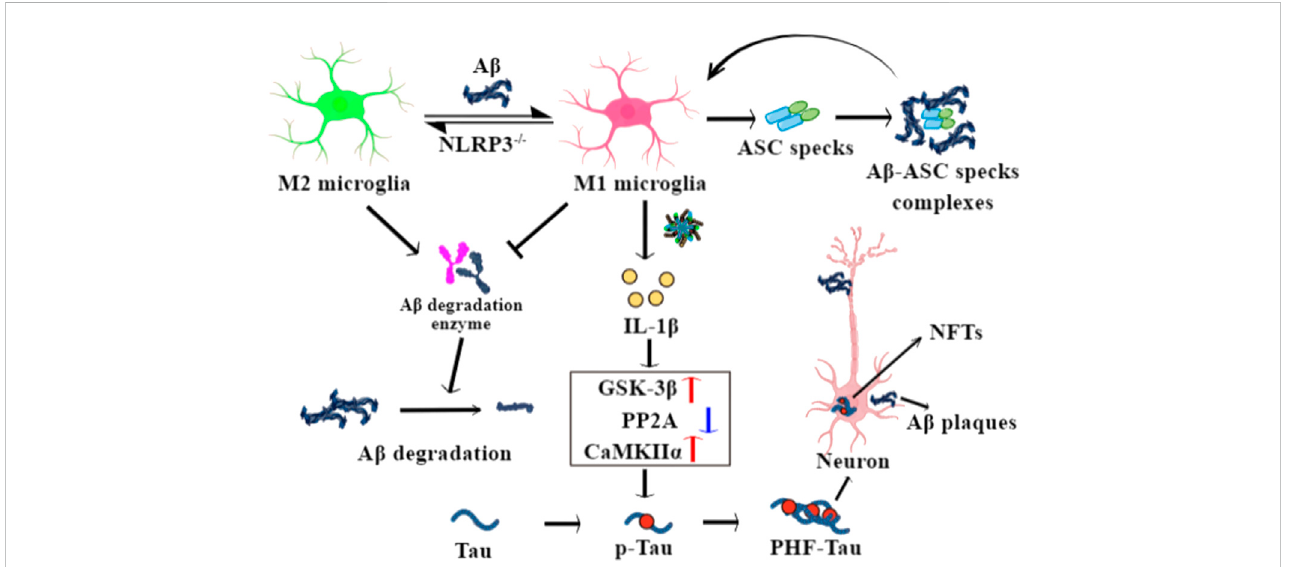
FIGURE 2 TheroleofNLRP3in fl ammasomeinthepathophysiologicalprocessesofAlzheimer ’ sdisease(AD).A β drivesamicroglialswitchfromtheprotectiveM2to the in fl ammatory M1 phenotypes after binding with TLR4, while NLRP3 knockout reverses it. M1 microglia show decreased phagocytosis ability and low expression of A β degradation enzymes, leading to A β deposits. Meanwhile, secreted ASC specks from pyroptotic microglia bind to A β and seed the surrounding cells to further A β aggregation. IL-1 β released from M1 microglia enhances the activity of GSK-3 β and CaMKII α enzymes and inhibits PP2A activity in neurons, with phosphorylate tau forming paired helical fi lament (PHF)-tau and neuronal fi brillary